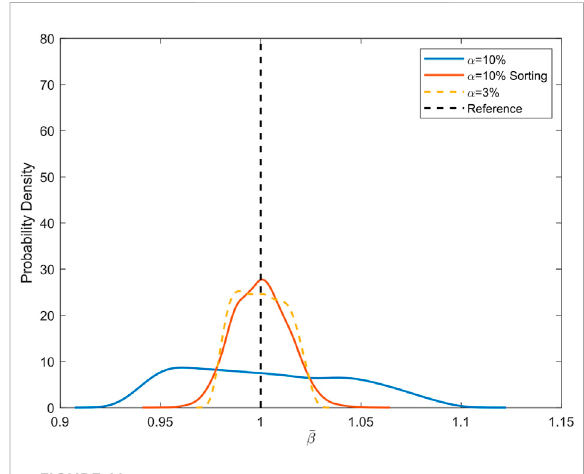
FIGURE 11 PDFs of the indicator with and without sorting strategy when disorder strength is 10%.